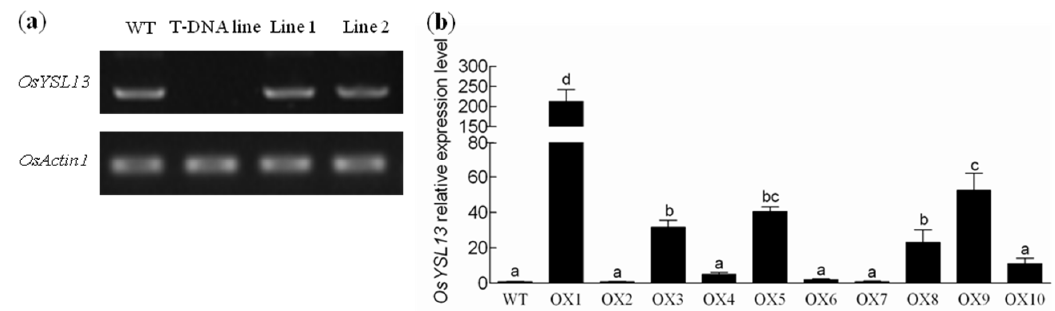
Figure 4. Expression identification of OsYSL13 in the T-DNA insertion line (RMD_04Z11MA04), complementation and overexpression lines. ( a ) Expression of the full length OsYSL13 transcript in the wild type, T-DNA insertion line (RMD_04Z11MA04) and two independent complementation lines. ( b ) Quantitative RT-PCR analysis of OsYSL13 in the wild type and overexpression lines. Relative expression level of OsYSL13 was compared with the expression in the wild type. Means with different letters were significantly different. ANOVA with a subsequent Duncan′s test was performed ( p < 0.05). Data were shown as means ± SD ( n = 3). All plant materials were grown in normal nutrient solution for 7 days . The roots were sampled for analysis. OsActin1 was used as an internal control.